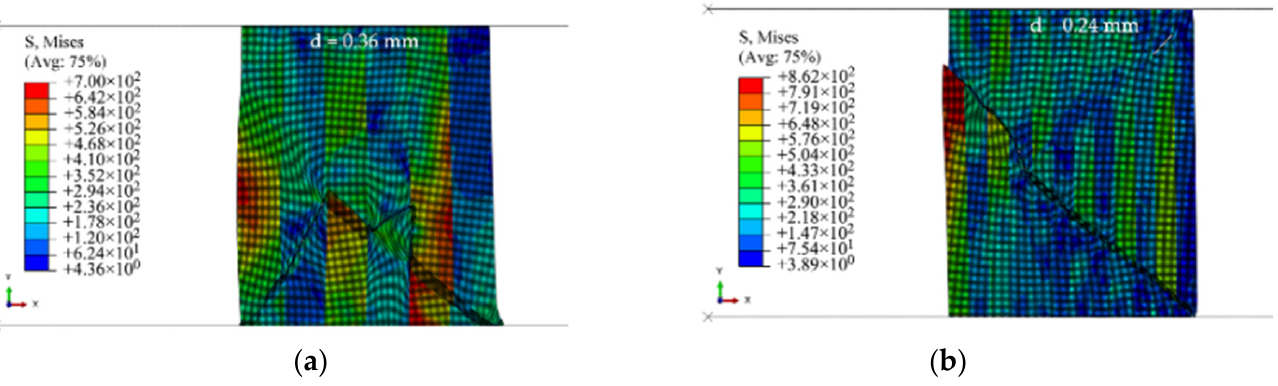
. Figure 20. Crack propagation path in ( a ) 3by3 model at 𝜀(cid:4662) (cid:3036) = 1 s − 1 and displacement level of d = 0.36 Figure 20. Crack propagation path in ( a ) 3by3 model at ε i = 1 s − 1 and displacement level of . mm and ( b ) 6by6 model at 𝜀(cid:4662) (cid:3036) = 4 s − 1 and displacement level of d = 0.24 mm. ε i = 4 s − 1 and displacement level of d = 0.24 d = 0.36mm and ( b ) 6by6 model at